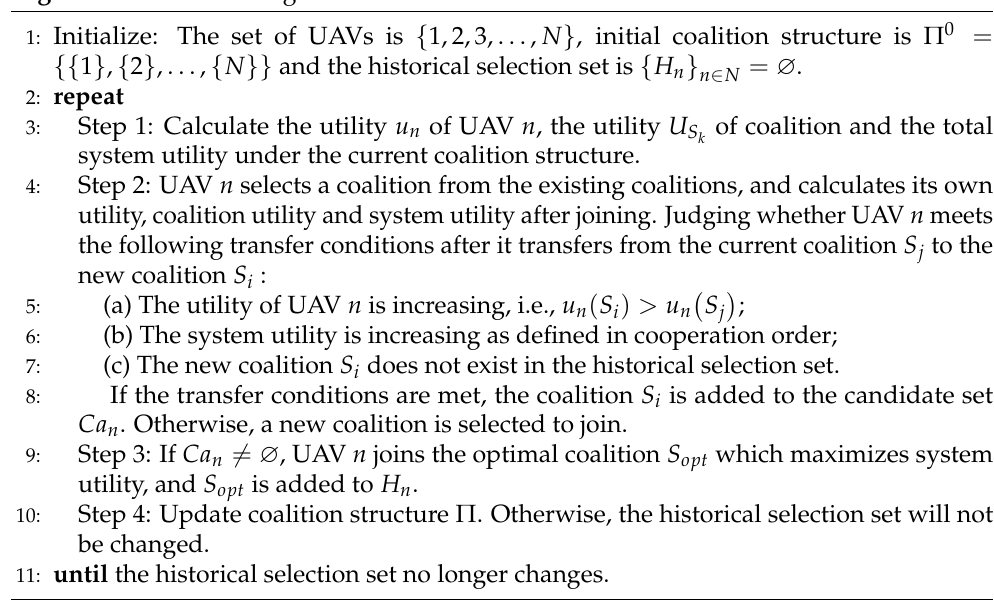
Algorithm 2 CO-CFG